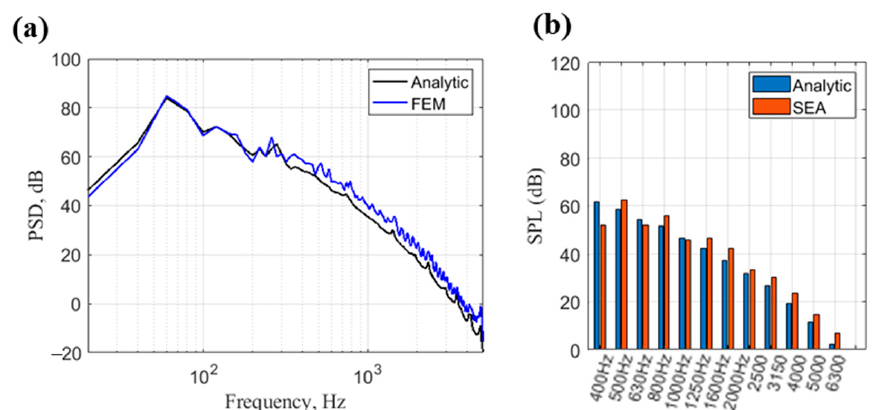
Figure 21. Comparison of numerical results with analytic results: ( a ) FEM model; ( b ) SEA model.